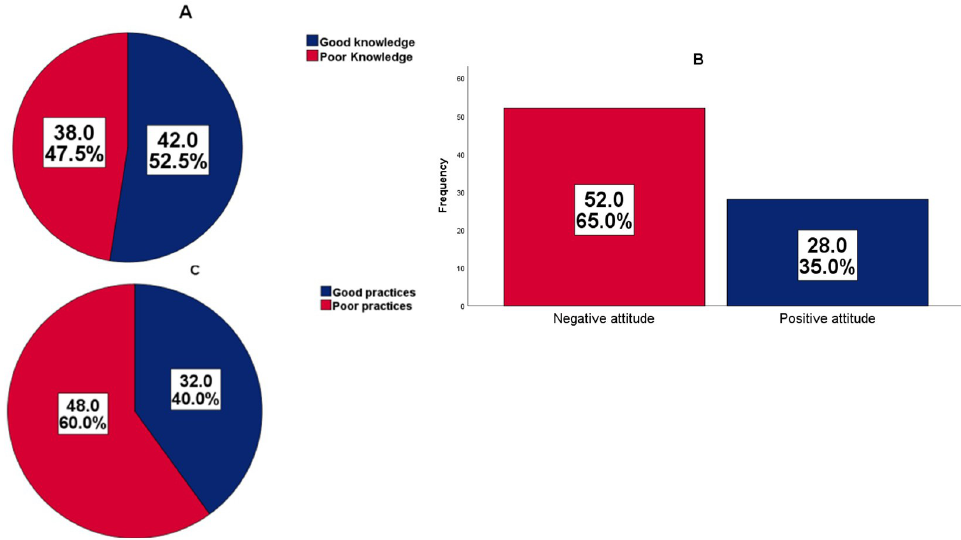
Fig 1. Levels of knowledge (A), attitude (B) and practices (C) of CHW on the management and prevention of childhood